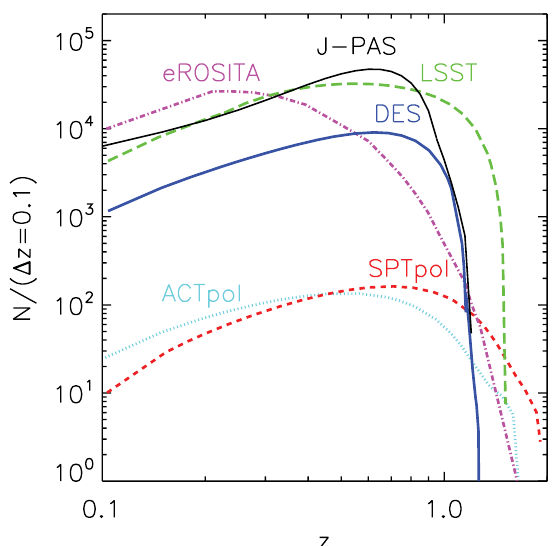
Figure 13. Total number of groups/clusters per redshift bin as a function of Figure 12. Total number of groups/clusters per redshift bin as a function of redshift for different redshift for different next-generation surveys: J-PAS (black solid line), DES next-generation surveys. From Reference (blue three dot–dashed line), LSST (green long dashed line), SPTpol (red short dashed line) and ACTpol (dotted cyan line). The J-PAS will detect similar number of clusters and groups as the LSST and eROSITA up to z 0.7, at least. ∼